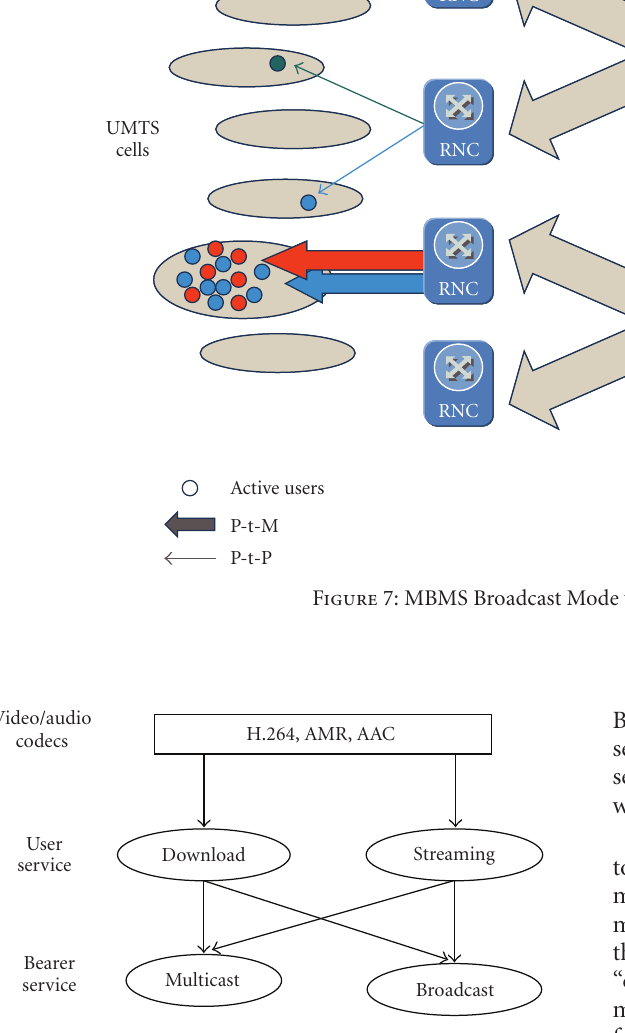
Figure 8: MBMS Bearer and User